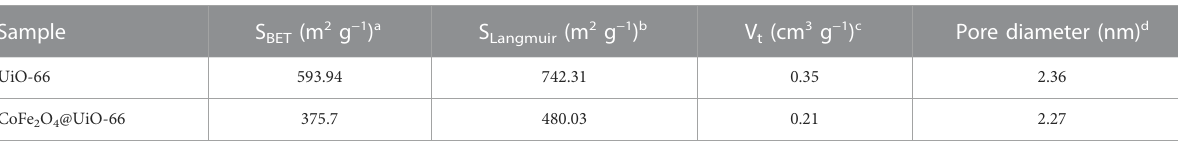
TABLE 1 Porous texture of the as-synthesized samples. Sample